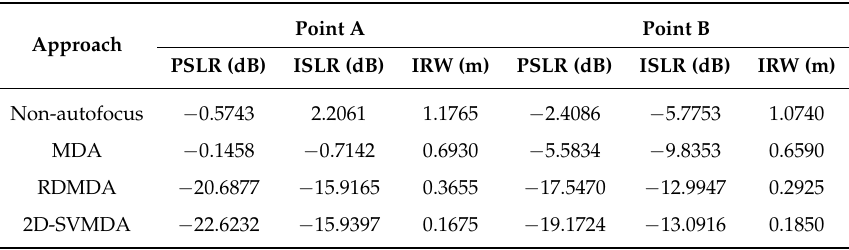
Figure 21. Azimuth impulse response curve comparison of point-like targets. ( a ) Azimuth response of Point A. ( b ) Azimuth response of Point B. Table 11. Statistical focus comparison of Non-autofocus, MDA processed, RDMDA processed, and 2D-SVMDA processed Point A and